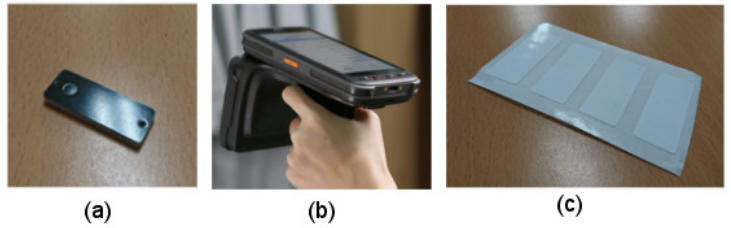
Figure 11. Used RFID UHF used elements used to identify the assets: ( a ) RFID UHF GEN II rigid solid TAG for metallic assets. ( b ) Android-based RFID UHF GEN II portable reader hand-held model